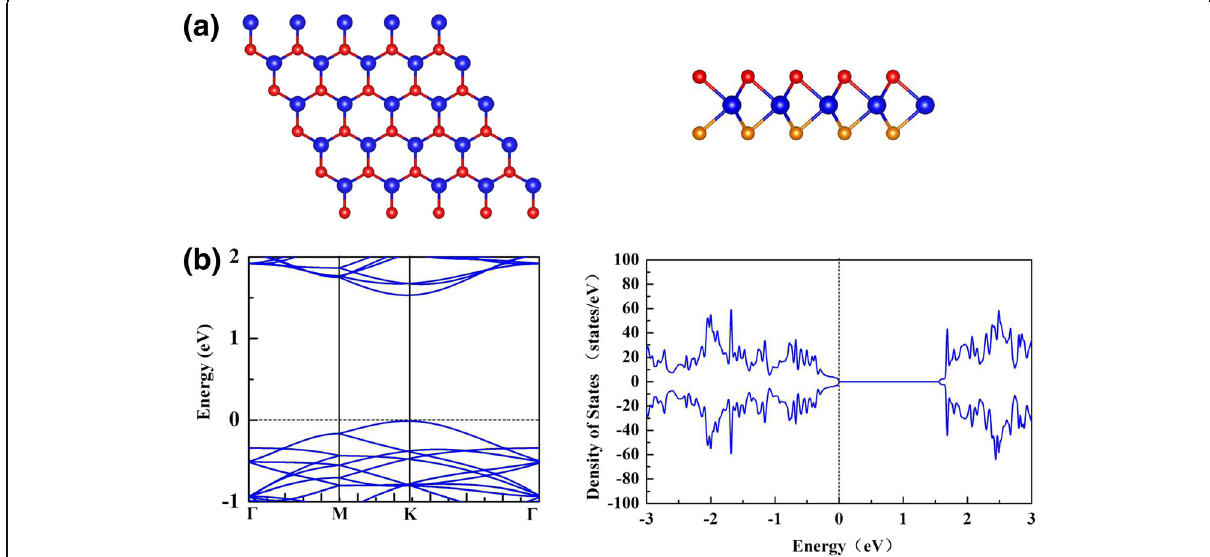
Fig. 1 a Top and side views for the atomic structure of monolayer WSe 2 . b The electronic band structure and density of states (DOS) of monolayer WSe 2 . The blue, red, and tangerine balls represent Wand Se atoms on the top and bottom layer, respectively. Fermi level is set as 0